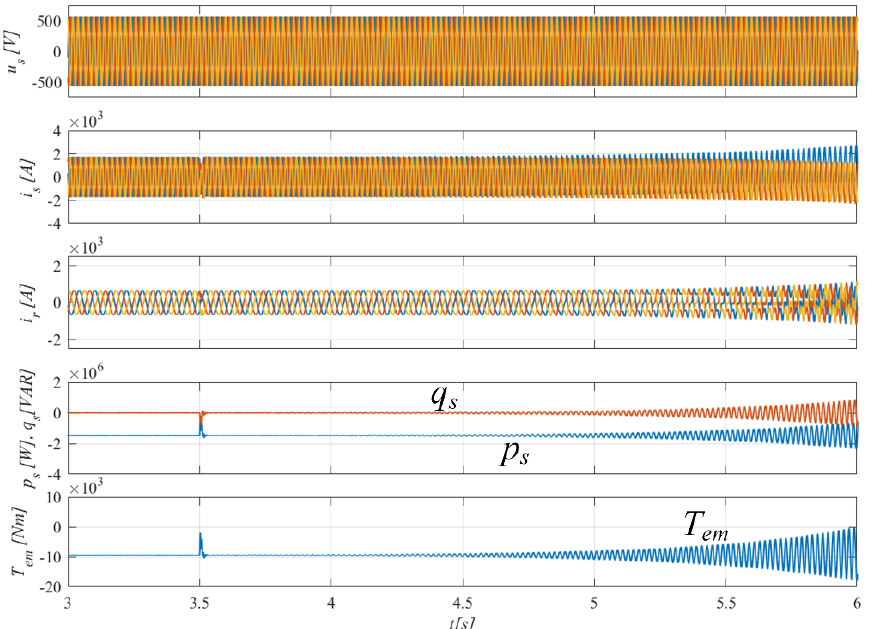
Figure 7. Direct power control simulation results of DFIG in case of symmetrical grid voltage with no feedforward and decoupling mechanism implemented.